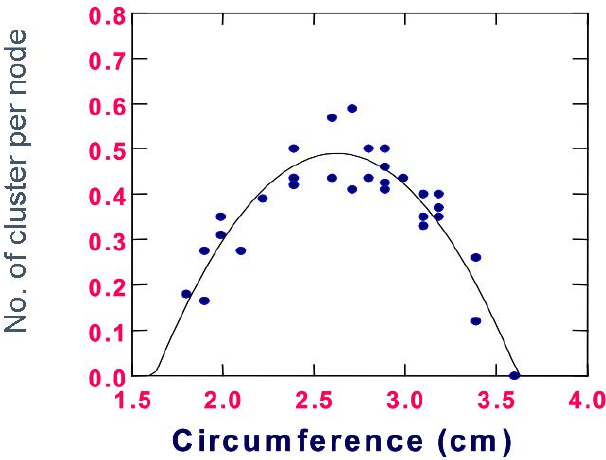
Figure 9. Quadratic regression between fertility (no. of cluster per node) and cane circumference measured at 600 mm from the collar. Source: see [36].